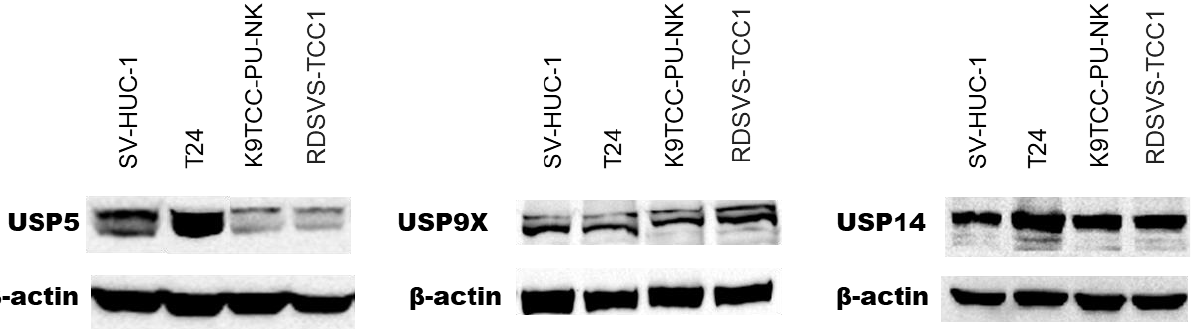
Figure 1. Representative graphical results of Western blot analyses showing expression of USP5, USP9X and USP14 in tested cell lines. USP = ubiquitin-specific protease.